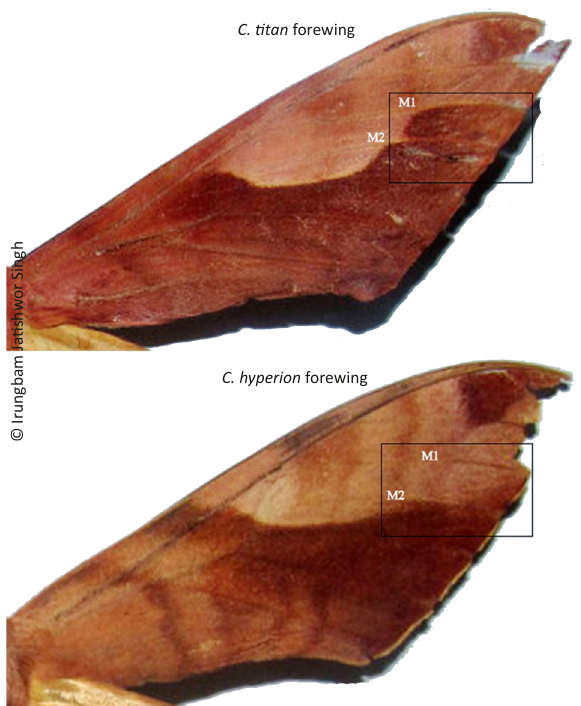
Image 1. Comparison of forewings between C. titan and C. hyperion showing the extension of pale apical region of C. hyperion beyond vein